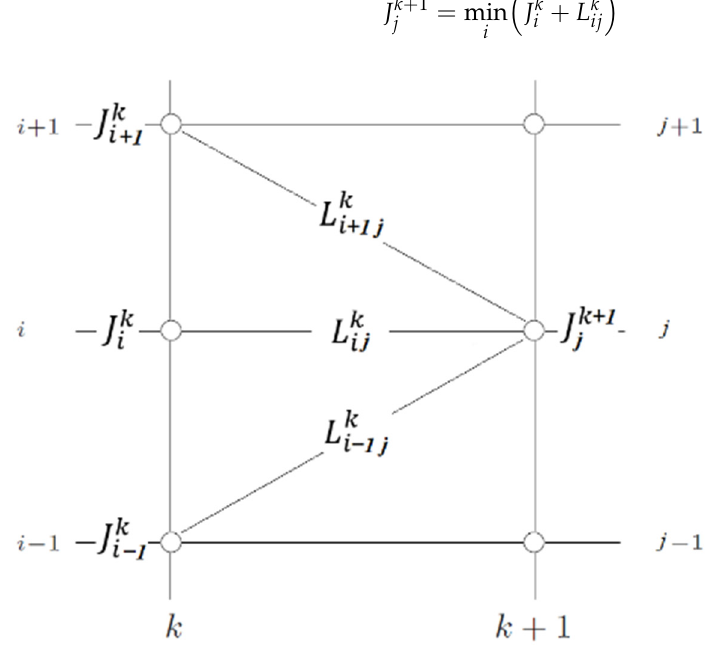
Figure 1. Schematic representation of the Forward Approach to Dynamic Programming (FADP).